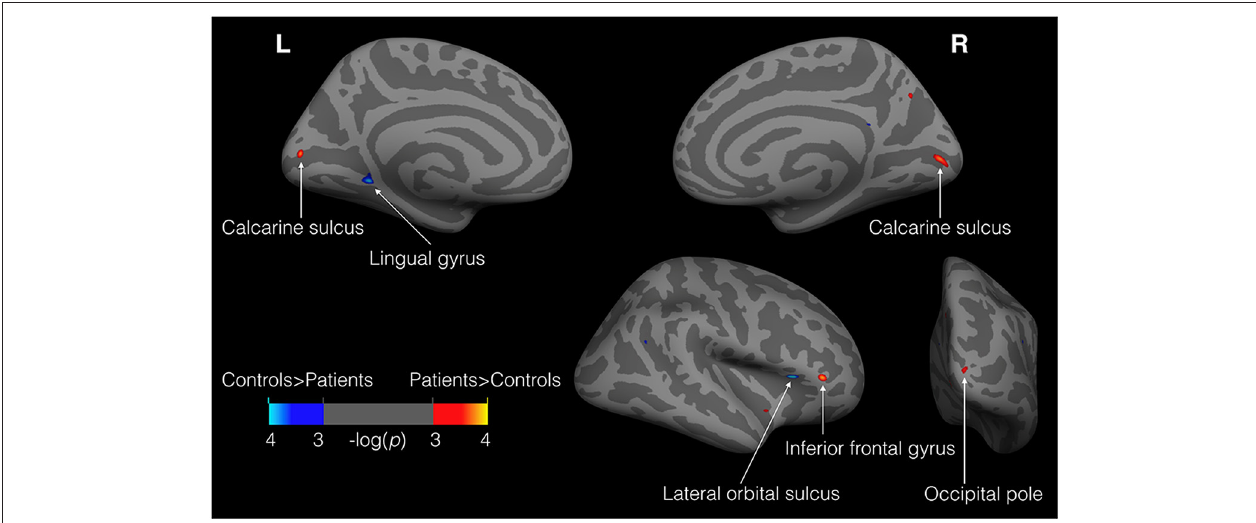
FIGURE 1 | Loci showing differences in cortical thickness between patients and controls (11 patients vs. 24 controls). Illustrated here are the results from GLM analysis on cortical thickness with group (patients vs. controls) and gender as fixed effects and age as covariate. Warm colors (red to yellow) represent areas where patients have thicker cortex than the controls, while cold colors (blue to cyan) represent the reverse. The maps were thresholded at P < 0.001 (uncorrected). Only clusters > 30 mm 2 are labeled.